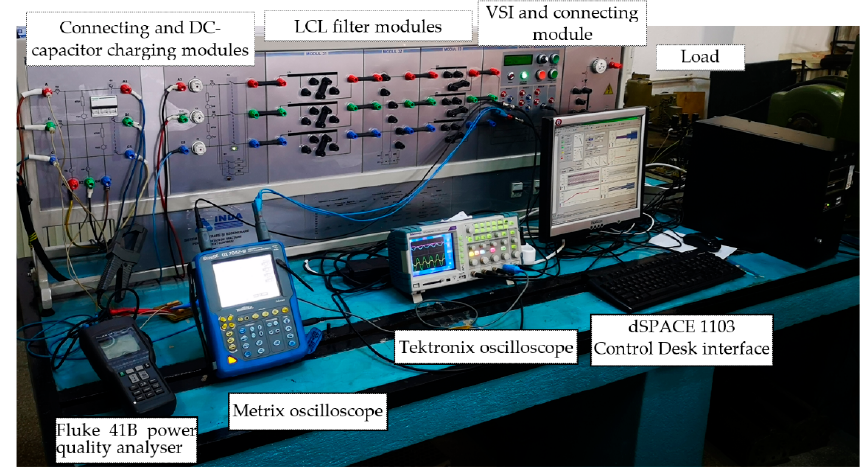
Figure 17. Experimental bench of SAPF system.